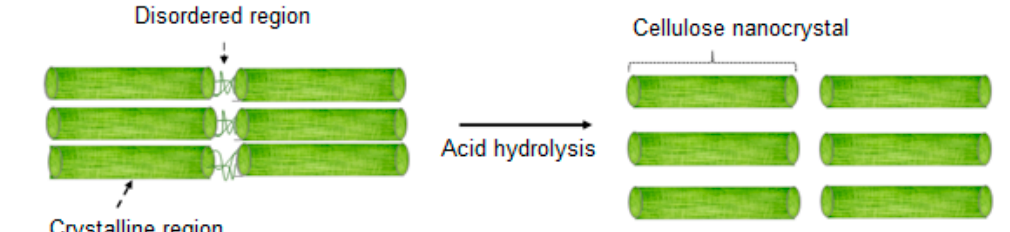
Figure 4. Scheme of isolation of cellulose nanocrystals by acid hydrolysis.